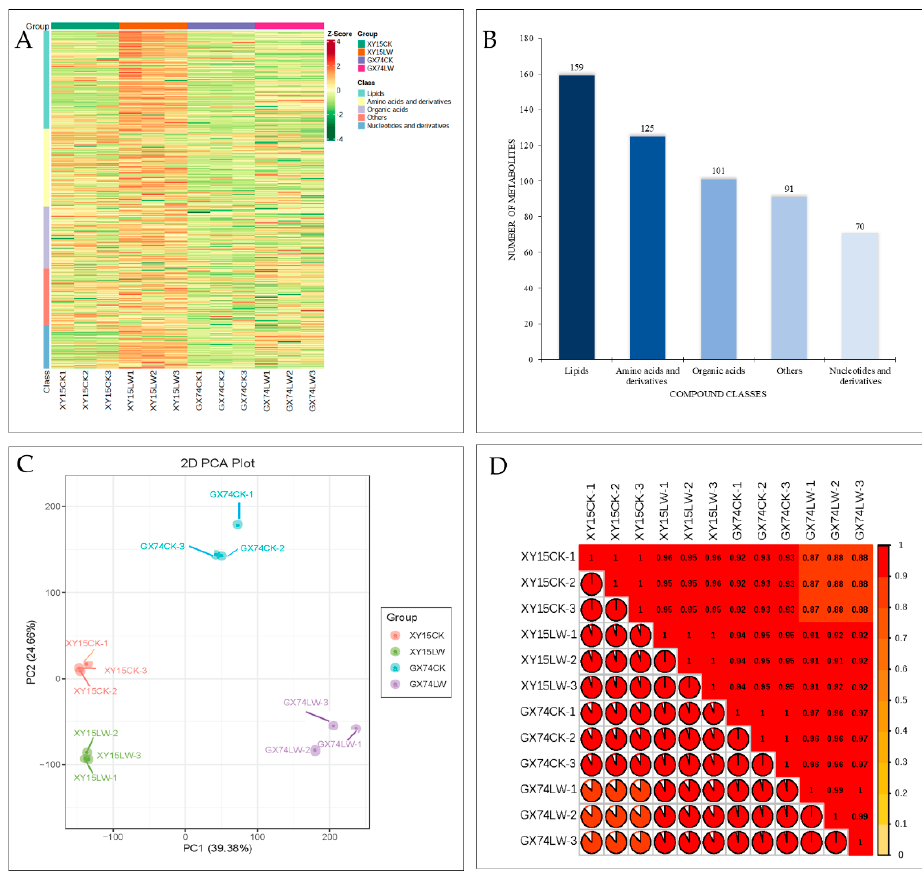
Figure 2. Metabolome analysis of rapeseed siliques treated with cold stress. ( A ) Heatmap of the relative intensities of the accumulated compounds. ( B ) Compound classification. ( C ) Principal component analysis. ( D ) Pearson’s correlation coefficient of the relative intensities of the compounds accumulated in rapeseed siliques in response to cold-stress treatment. Where XY15 and GX74 are cold-sensitive and -tolerant genotypes, respectively, and CK and LW are control and cold treatment, respectively. The numbers with the treatments represent the replicates.